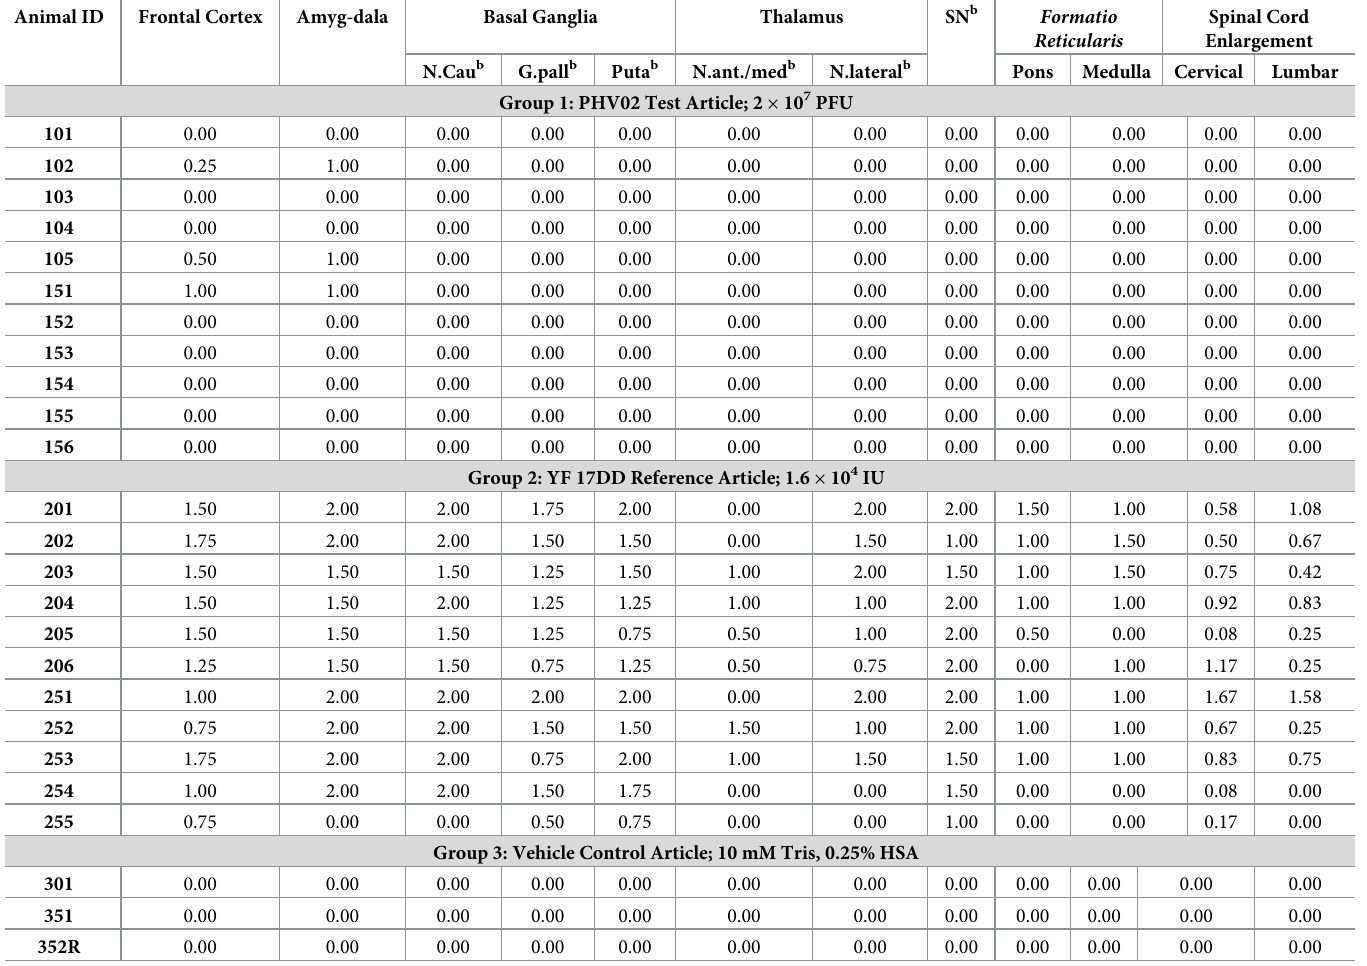
Table 2. Monkey Neurovirulence Test: Individual Brain and Spinal Cord Scores a , Cynomolgus Macaques, evaluated 30 days after inoculation. Animal ID Frontal